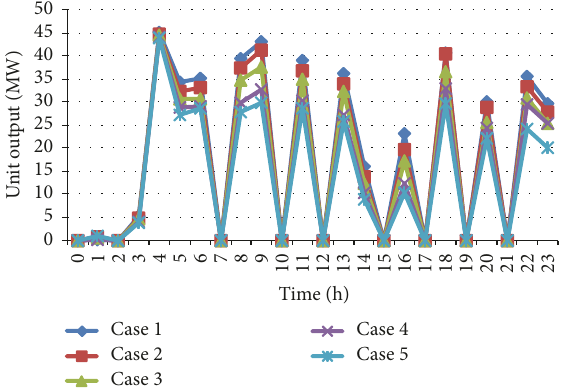
Figure 8: Energy storage power downregulation reserve bidding capacity.